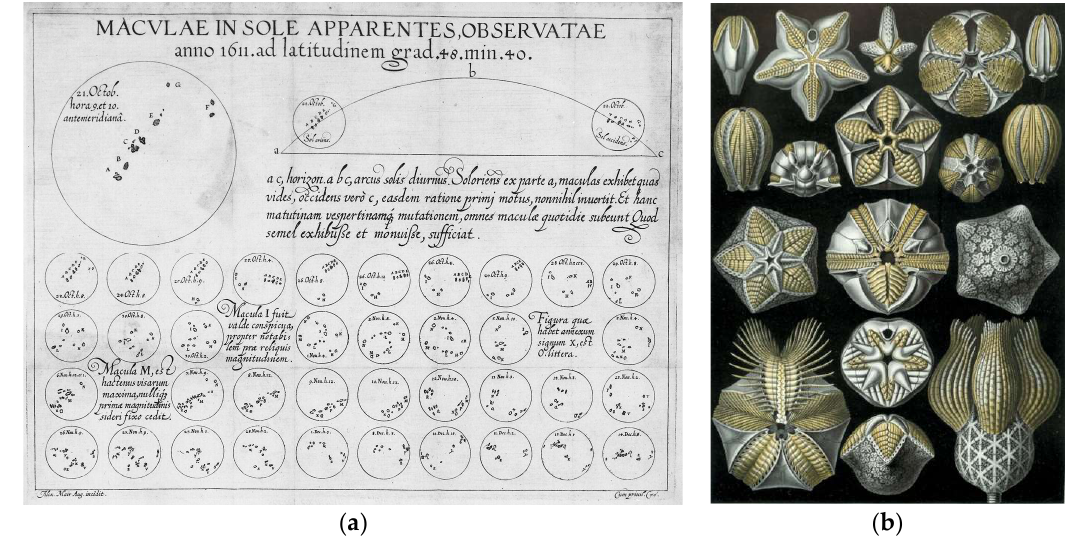
Figure 2. ( a ) Scheiner, C. Rosa Ursina , 1626–1630; ( b ) Haeckel, H. Kunstformen der Natur , 1904, plate